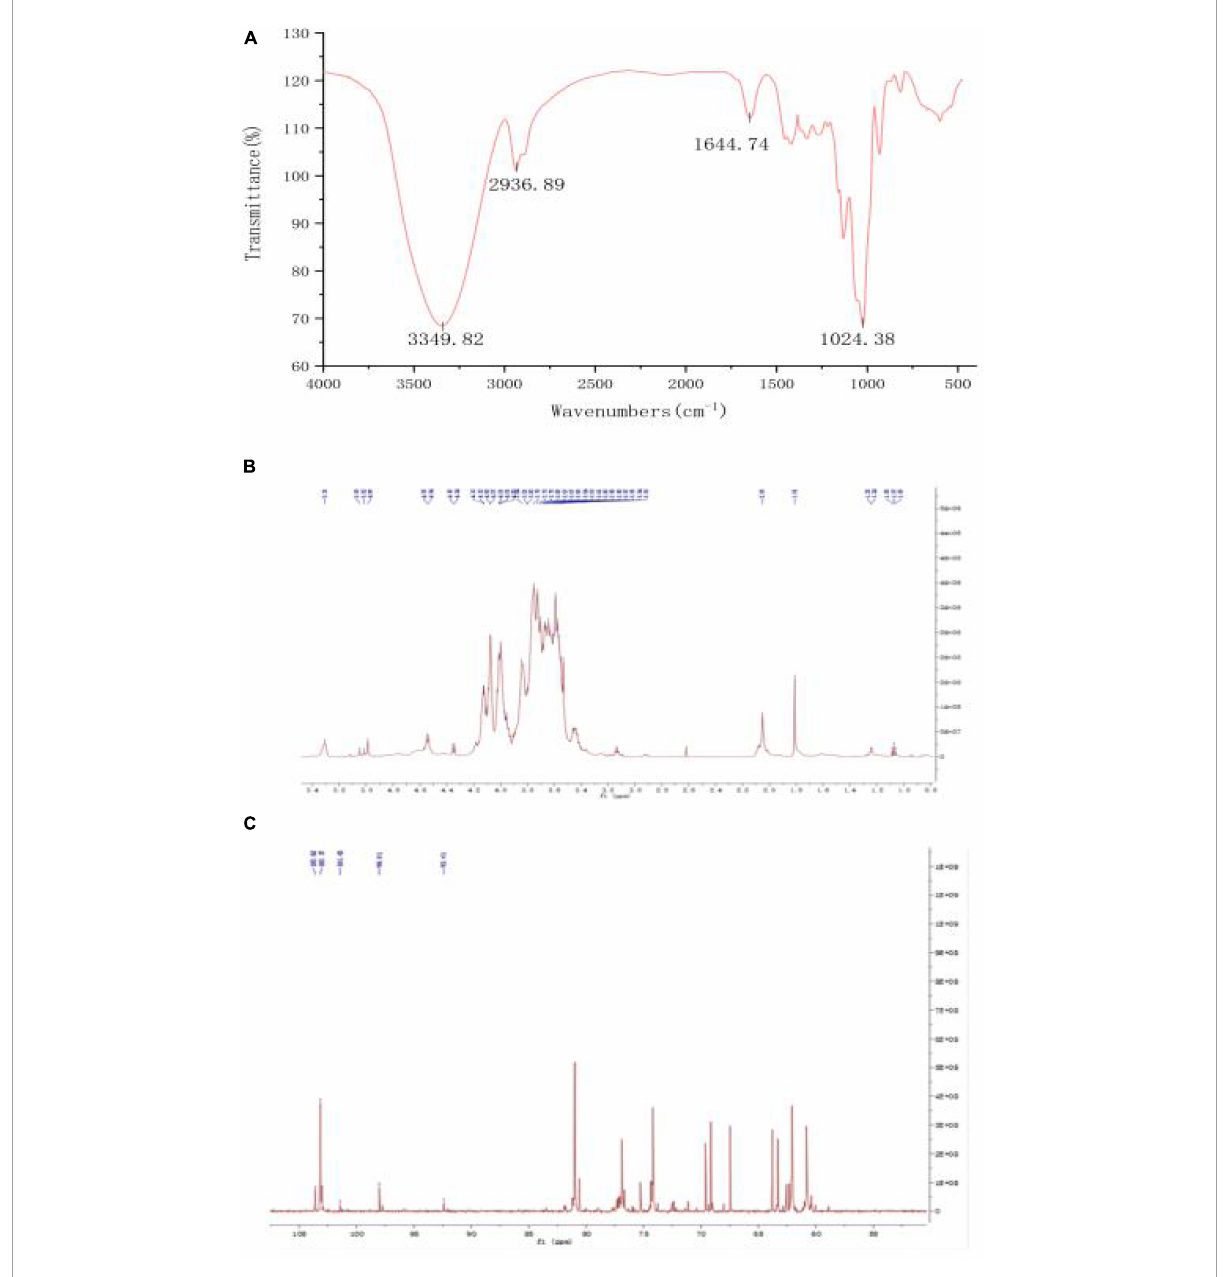
FIGURE3 Structure elucidation of PSP-NP. (A) FT-IR spectrum. (B) 1H NMR spectrum. (C) 13C NMR spectrum.